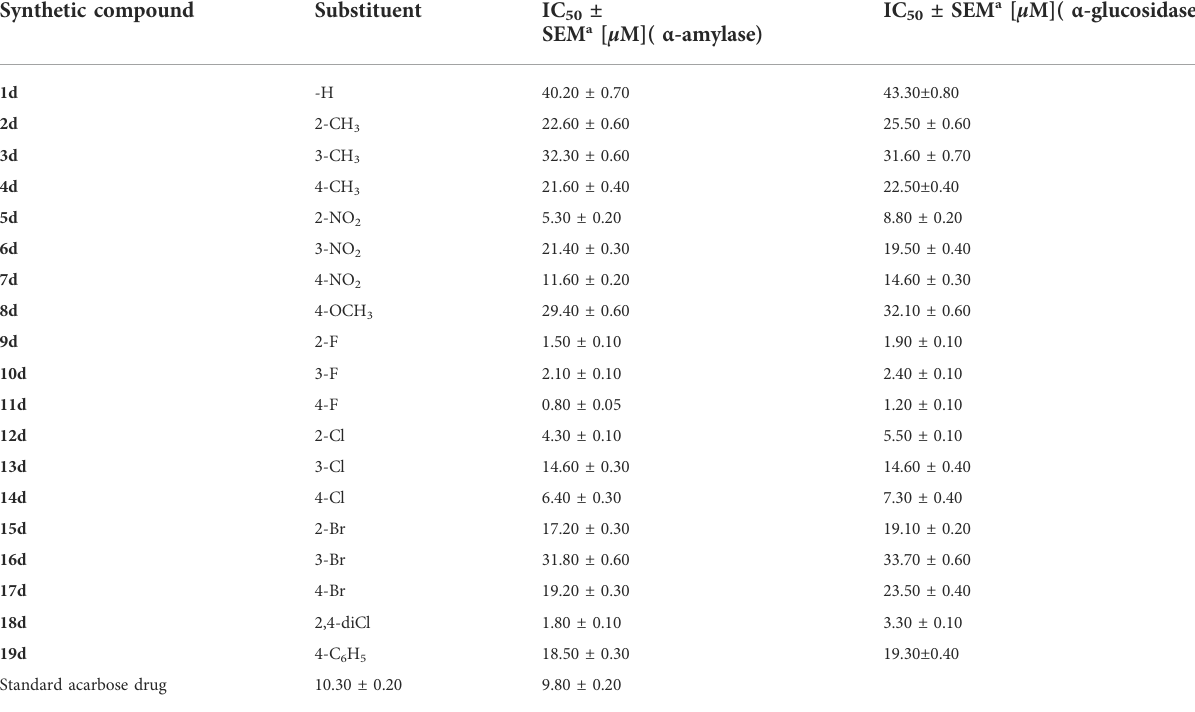
TABLE 1 Inhibition pro fi le ( in vitro ) of targeted α -amylase and α -glucosidase enzymes of hybrid scaffolds of quinoline-based triazole (1d – 19d). Synthetic compound